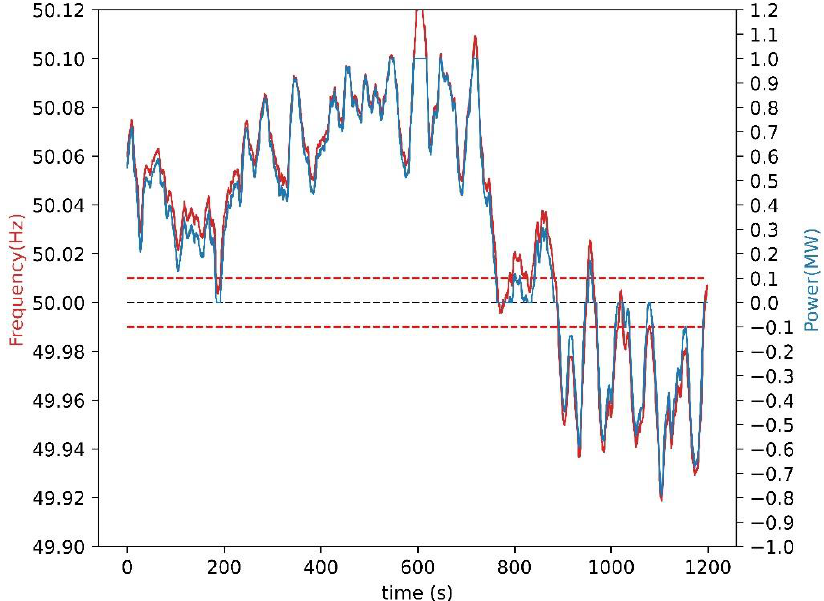
Figure 5. Power as a function of frequency (Equations (5) and (6)) for the time period 4 September 2020 00:32:59–00:52:59. Red horizontal lines are the deadband limits. Black horizontal line is the nominal frequency and the battery idle state. Table 3. Parameters of the battery in